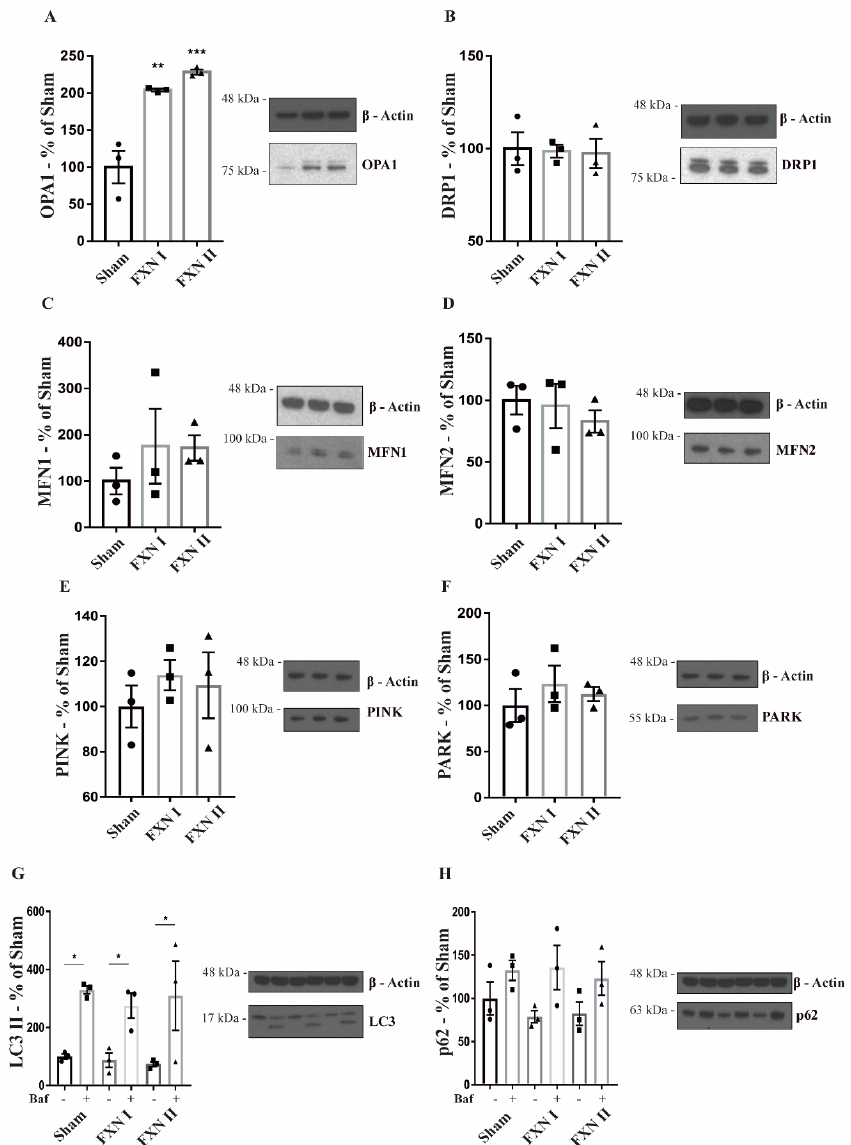
Figure 5. Western blot analysis of mitochondrial dynamics and quality control-related proteins in OE-MS cells. Cells were either left untransduced (Sham) or transduced with Lv-FXN I or Lv-FXN II. ( A ) Analysis of OPA1 levels in OE-MS patient cells. ( B ) Analysis of DRP1 levels in OE-MS patient cells. ( C ) to ( D ) Analysis of MFN1 and MFN2 levels in OE-MS patient cells. ( E ) to ( F ) Analysis of PINK/PARK levels in OE-MS cells. ( G ) to ( H ) Analysis of LC3 and p62 levels with and without autophagy inhibitor bafilomycin A1. Data are represented as mean ± SEM and were analyzed with a one-way ANOVA with post hoc Dunnett multiple comparisons test with n = 3. * p < 0.05; ** p < 0.01; *** p < 0.001.